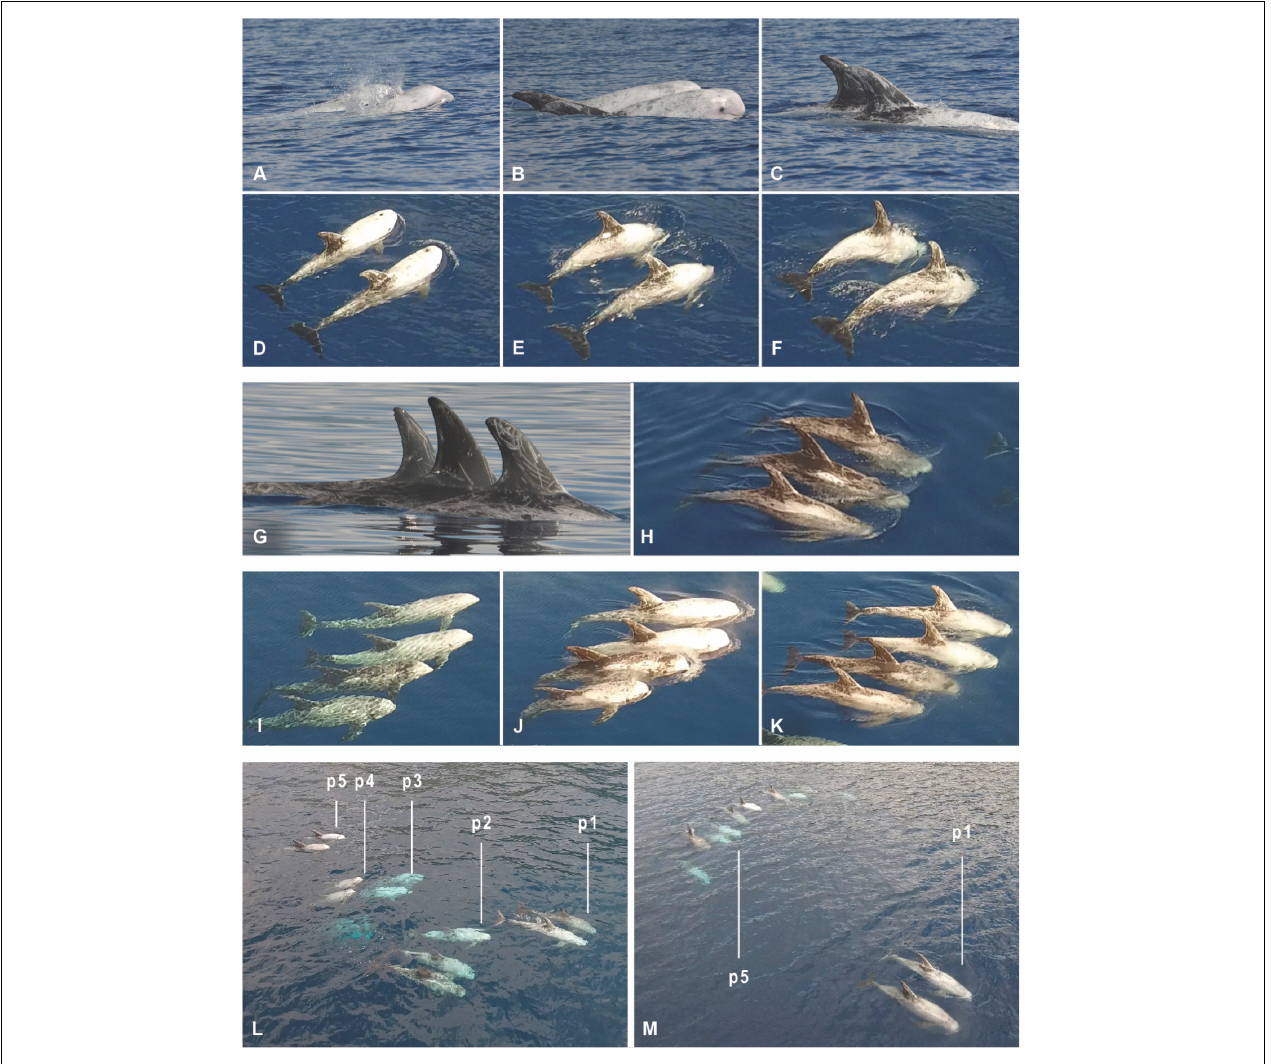
FIGURE 2 | Examples of individual identification and group compositions used for scoring relative positions of individuals. (A–C) Photo identification of a synchronized pair using conventional photo identification methods. (D–F) Same pair, captured by the UAV. (G) Photo identification of a synchronized triplet. (H) Same triplet, captured by the UAV. (I–K) Photo identification of a synchronized quartet, captured by the UAV. (L) The IKB group organized in 5 rows, using a relative classification for individual positions categorized as: front row (p1), row behind the front (p2), center (p3), row before the rear (p4), or rear row (p5). (M) The IKB group organized in 2 rows: front (p1) and rear